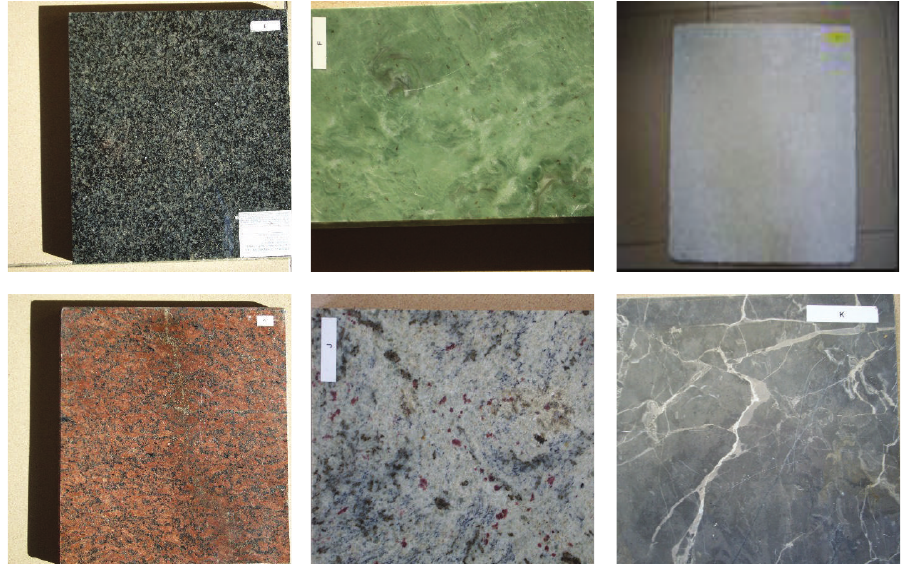
F 5: Six of the 16 marble slabs used for the test